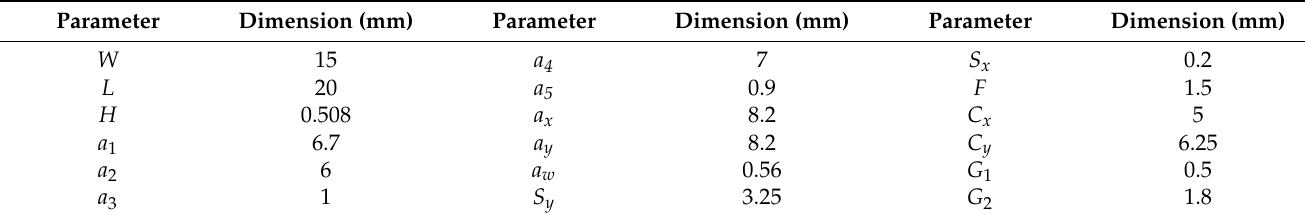
Figure 1. Configuration of the proposed antenna: ( a ) Front view and ( b ) side view. Table 1. Optimized parameters of the antenna. Table 1. Optimized parameters of the antenna.